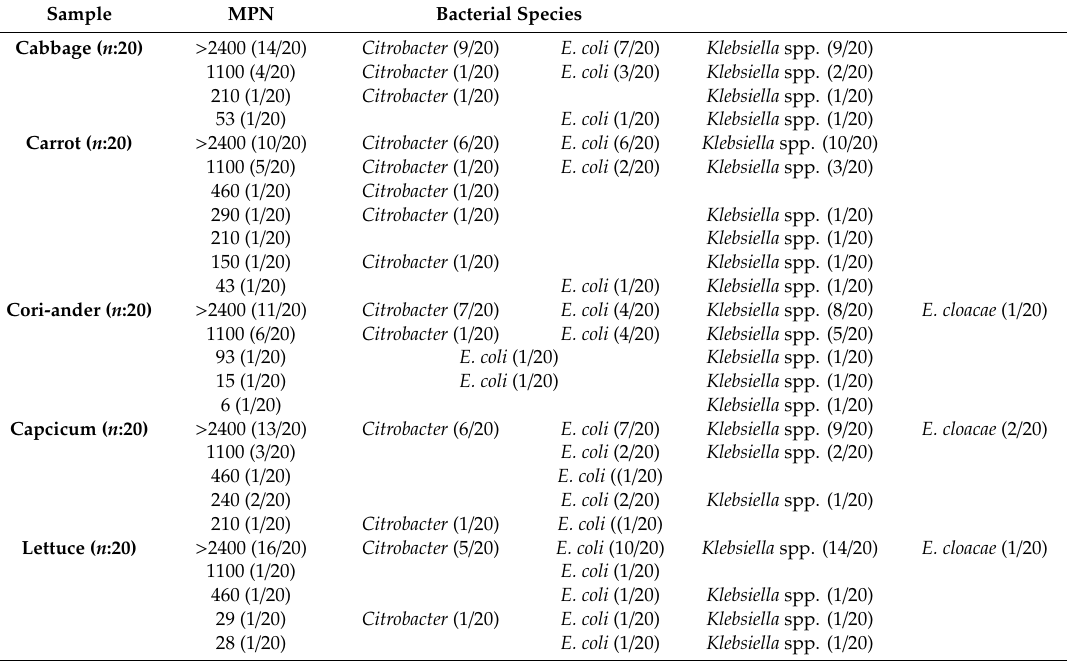
Table 1. Most Probable Number (MPN) table of Coliform bacteria isolated from raw vegetable samples from the Kathmandu